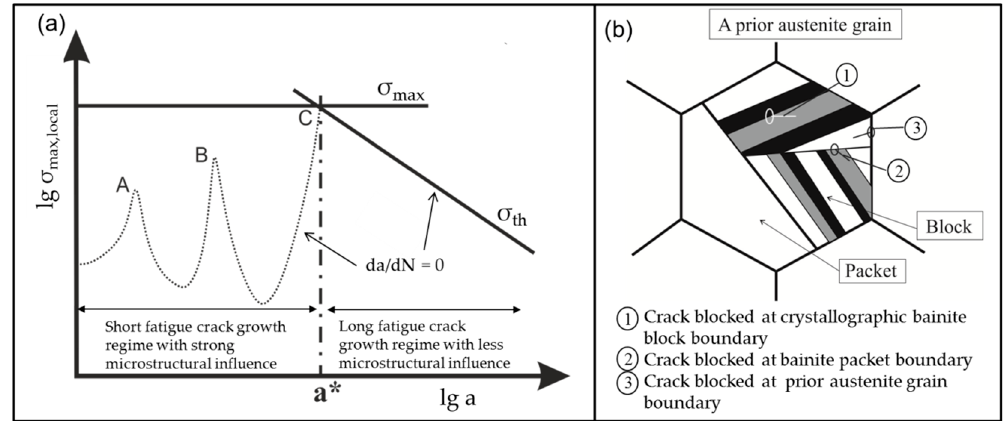
Figure 1. ( a ) Scheme of Kitagawa diagram according to [10]; and ( b ) scheme of nanobainitic microstructure according to [11] with possible barriers for a growing fatigue crack.